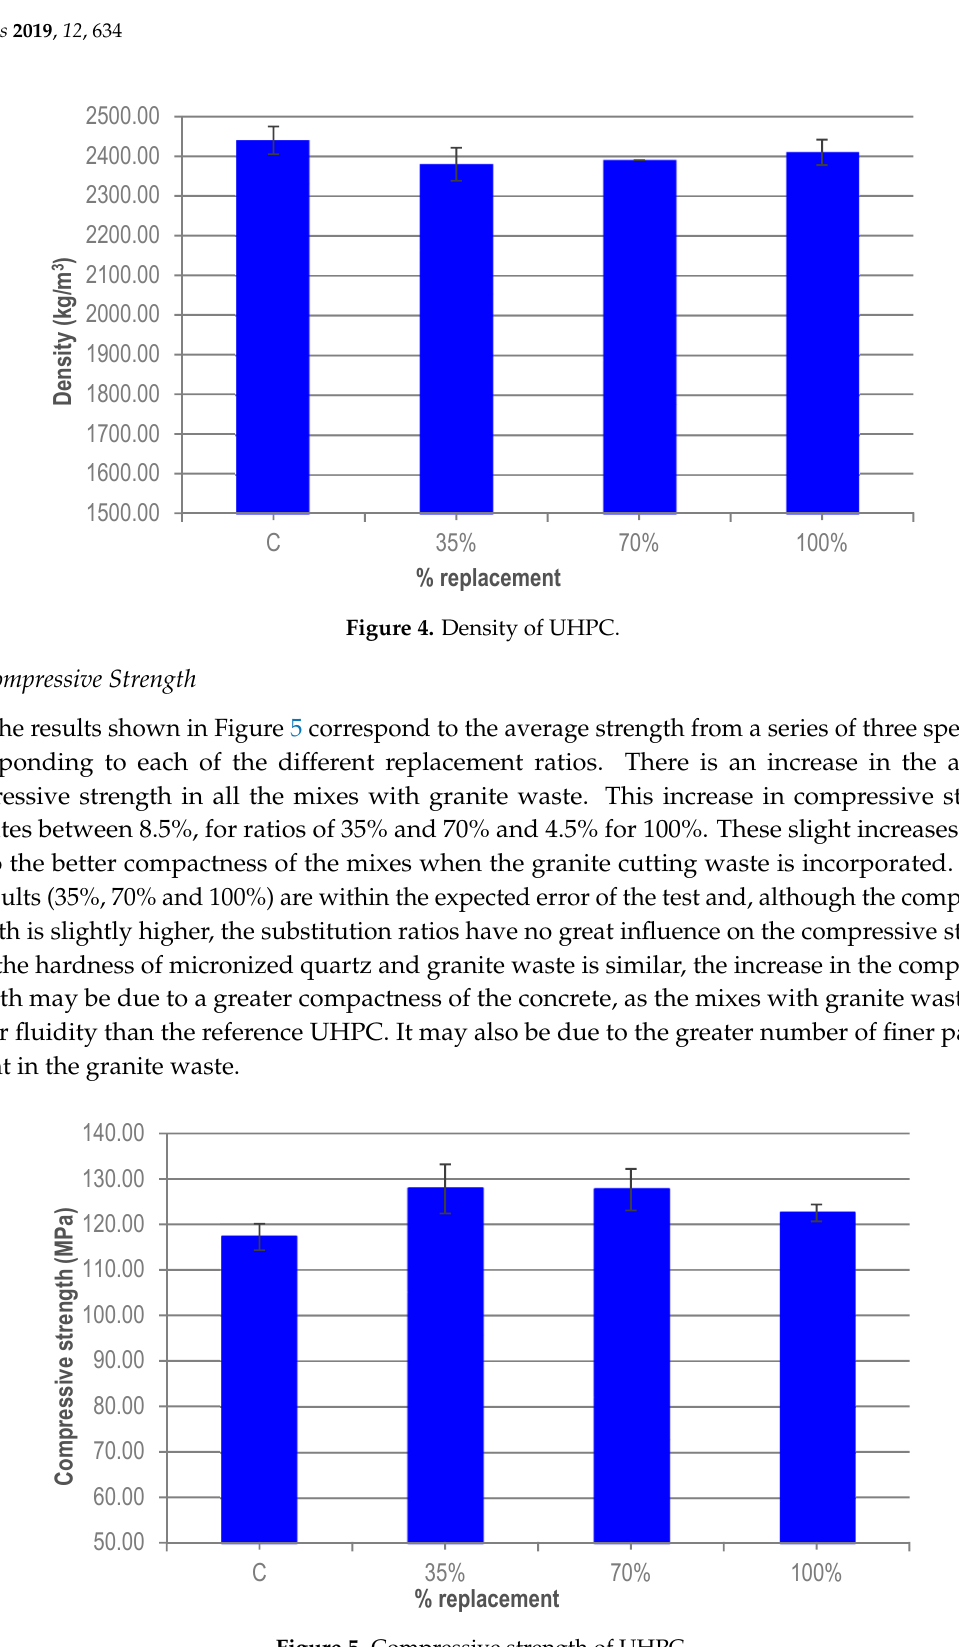
Figure 5. Compressive strength of UHPC .